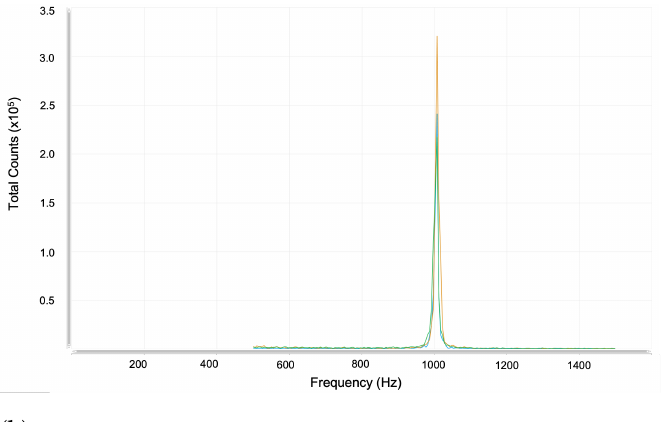
Figure 4. Illustrative example displaying ELS experiment results obtained for three consecutive measurements (blue, green, and orange curves) of the same sample. ( a ) Plot for the fast field reversal phase vs. time. ( b ) Plot for the frequency shift vs. time. Additional experimental data typically obtained from these plots are the quality factor of 1.37 ± 0.321, the zeta potential (mV) of − 13 ± 0.506, the conductivity (mS cm − 1 ) of 12.4 ± 1.69, and the mobility (µm·cm/V·s) of − 1.02 ± 0.0395.